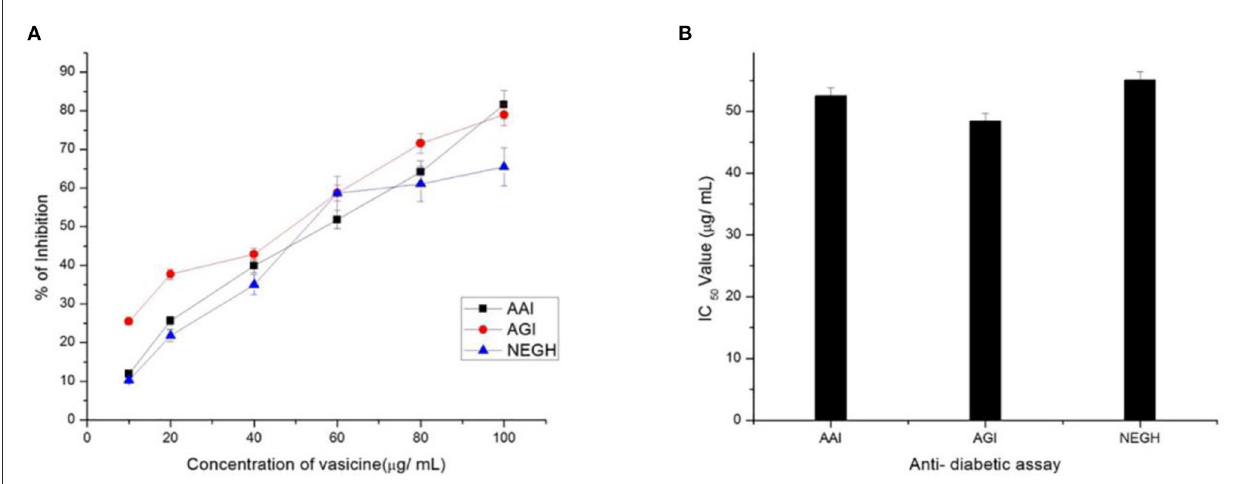
FIGURE6 (A) Percentage inhibition and (B) IC 50 Value of vasicine. AAI, α -amylase inhibition assay; AGI, α -glucosidase enzyme; NEGH, non-enzymatic glycosylation of hemoglobin assay.